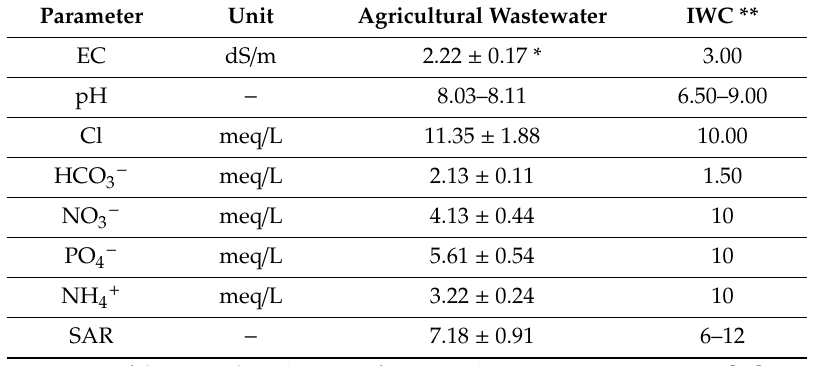
Table 1. The chemical analysis of the real agricultural wastewater used in the